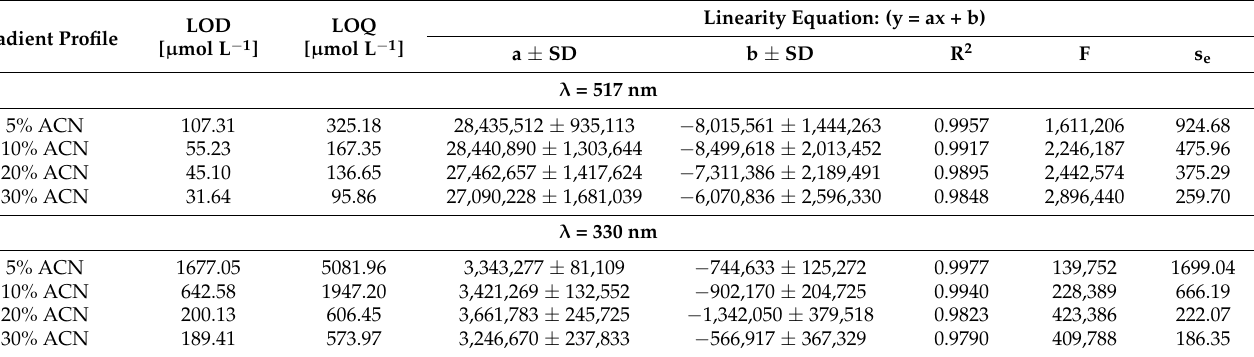
Table 1. Parameters of the calibration curve investigated in the range of 0.5–2.5 mM, together with the limits of quantification (LOQ) and detection (LOD) for DPPH-R in gradient elution modes measured at 517 nm and 330 nm.